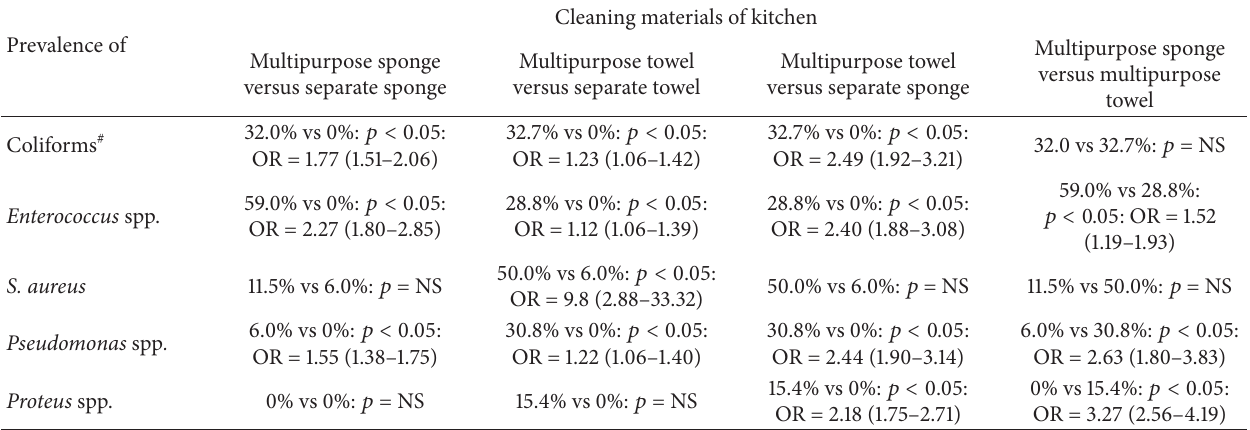
Cleaning materials of kitchen Multipurpose towel Multipurpose towel versus separate towel versus separate sponge